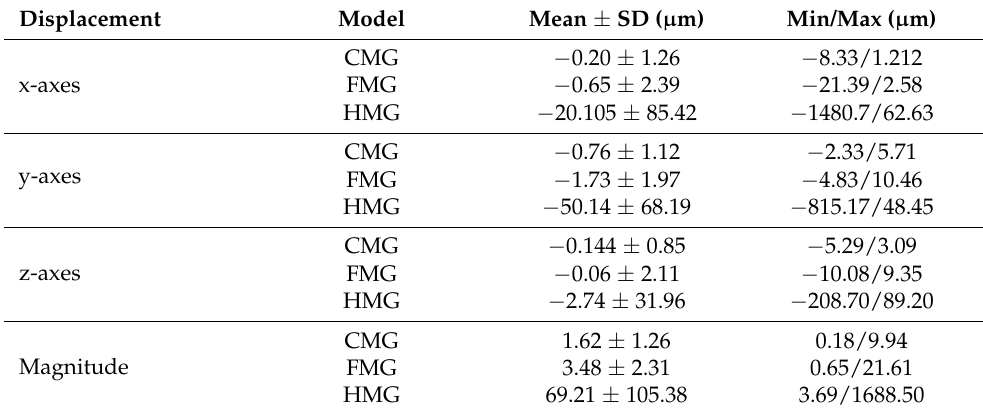
Table 4. Mean and range of displacements for the different mouthguard